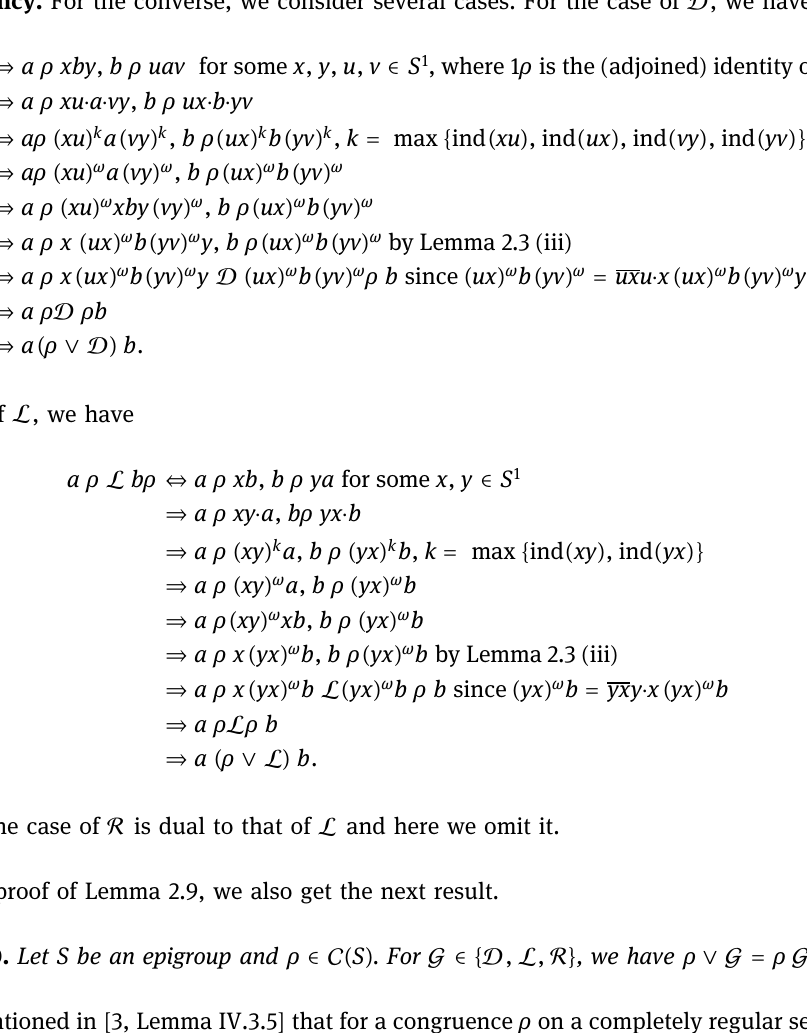
Figure 1. The family of subsets { ga , ag 2 } , { a , gag 2 } , { ag , gag 3 } , { ag 3 , gag } and all the singleton sets which are not contained in the four former subsets of S